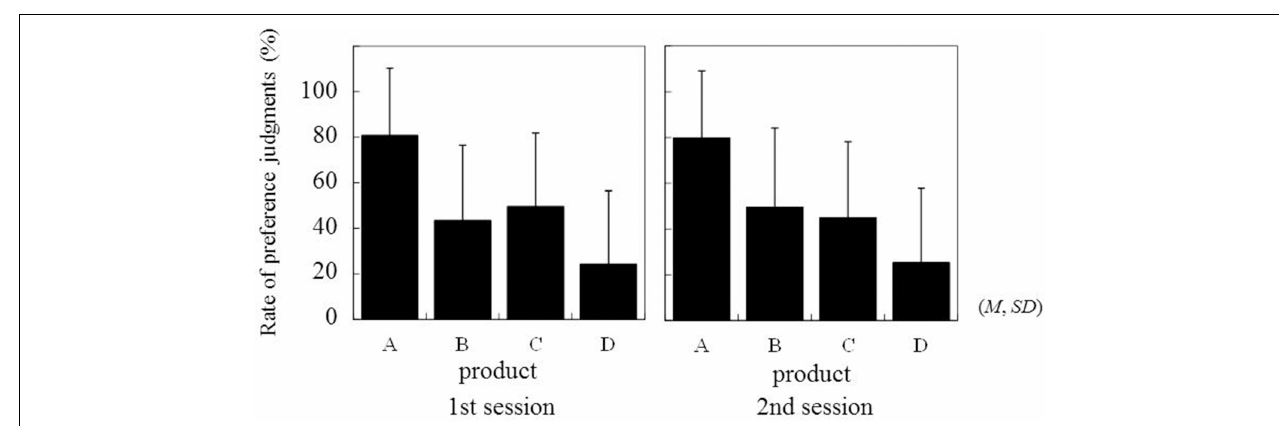
FIGURE 4 | Rate of preference judgment for each product in two sessions of the paired-comparison